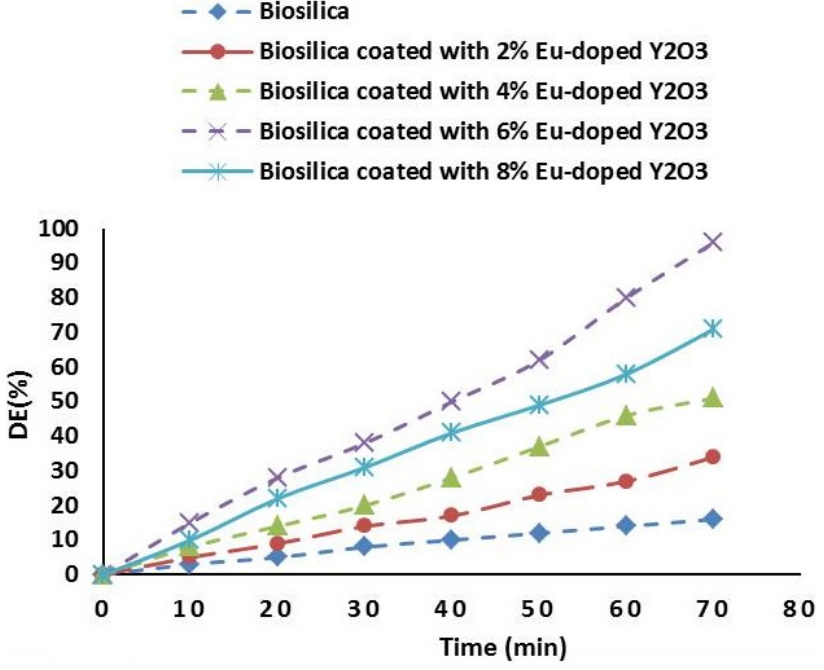
Figure 13. The decolorization of RB19 with different Eu 3+ content, [Dye] = 20 mg/L, [Catalyst] = 1.25 g/L, pH = 6.